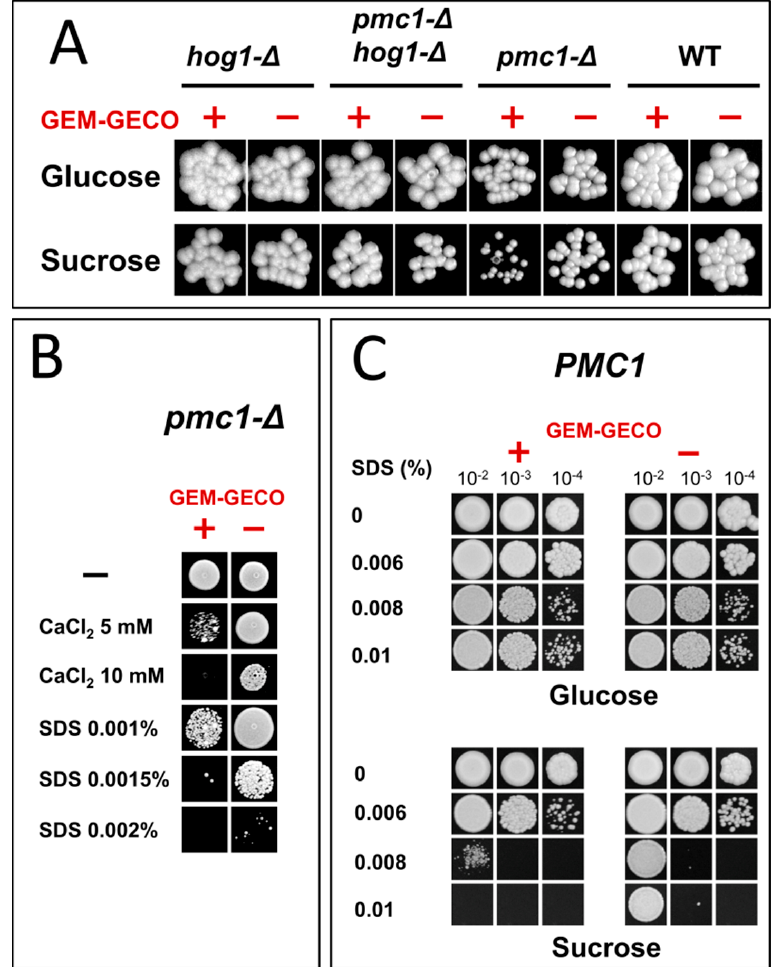
Figure 2. Growth of strains differing in the expression of the GEM-GECO cassette on YPD (Glucose) and YP-Suc (Sucrose) solid media. ( A ), Spotting of 10 − 4 -fold diluted YPD cultures on regular YPD and YP-Suc. WT, DL1-LC and DL5-LC strains; pmc1- Δ , DL5-pmc1-LC and DLdaduA-pmc1-LC strains; hog1- Δ , DL5-hog1 and DLdaduA-hog1-UC strains; pmc1- Δ hog1- Δ , DL5-pmc1-hog1 and DLdaduA-pmc1-hog1 strains. ( B ), Spotting of 10 − 4 -fold diluted YPD cultures of DL-pmc1 (GEM-GECO − ) and DL5-pmc1 (GEM-GECO +) on YPD with indicated supplements. ( C ), Spotting of 10 − 2 -, 10 − 3 -, and 10 − 4 -fold diluted YPD cultures of DL1-L (GEM-GECO − ) and DL5 (GEM-GECO +) on YPD and YP-Suc with indicated supplements.